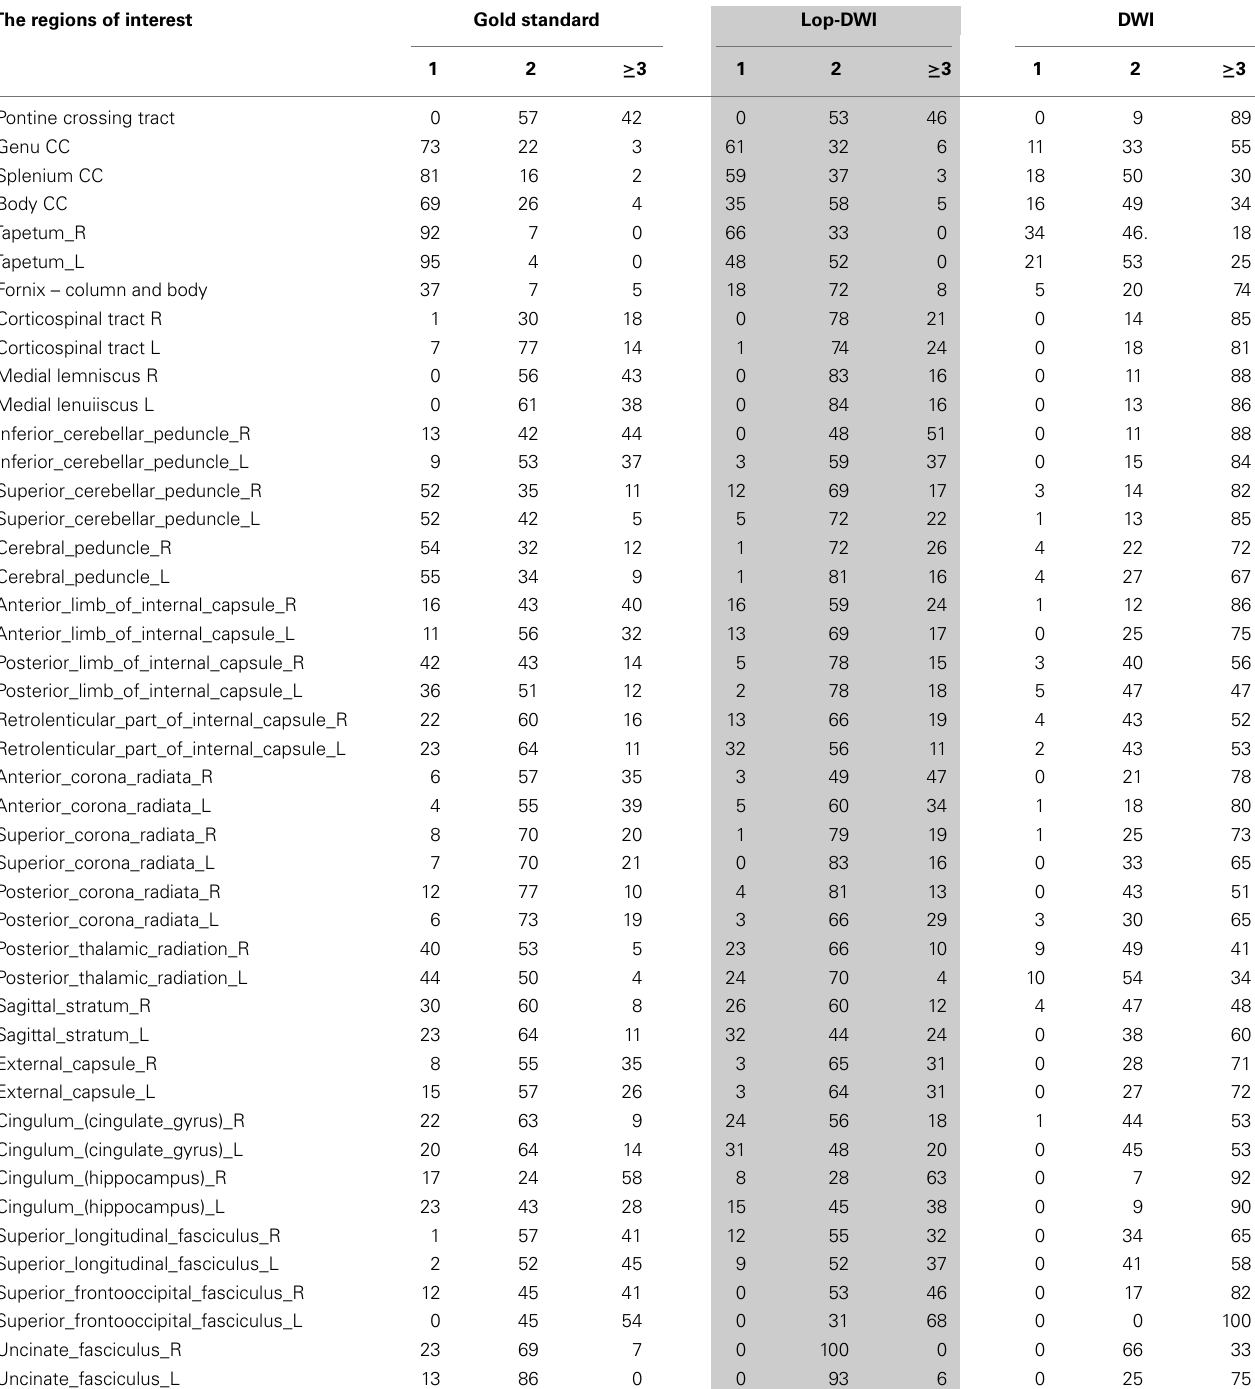
Table 2 | Percentages of voxels with single, two, or greater than three fiber populations across regions of white matter, estimated for gold standard (see Method), DWI, and lop-DWI (extended from Figure 9)